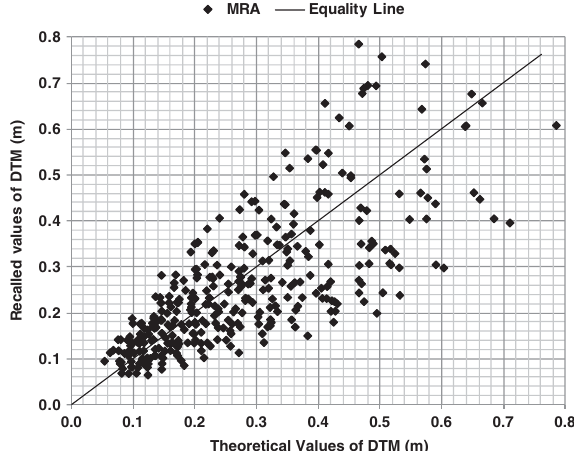
Fig. 12. Recalled D TM values by multiple nonlinear regres- sion vs. theoretical data (Set